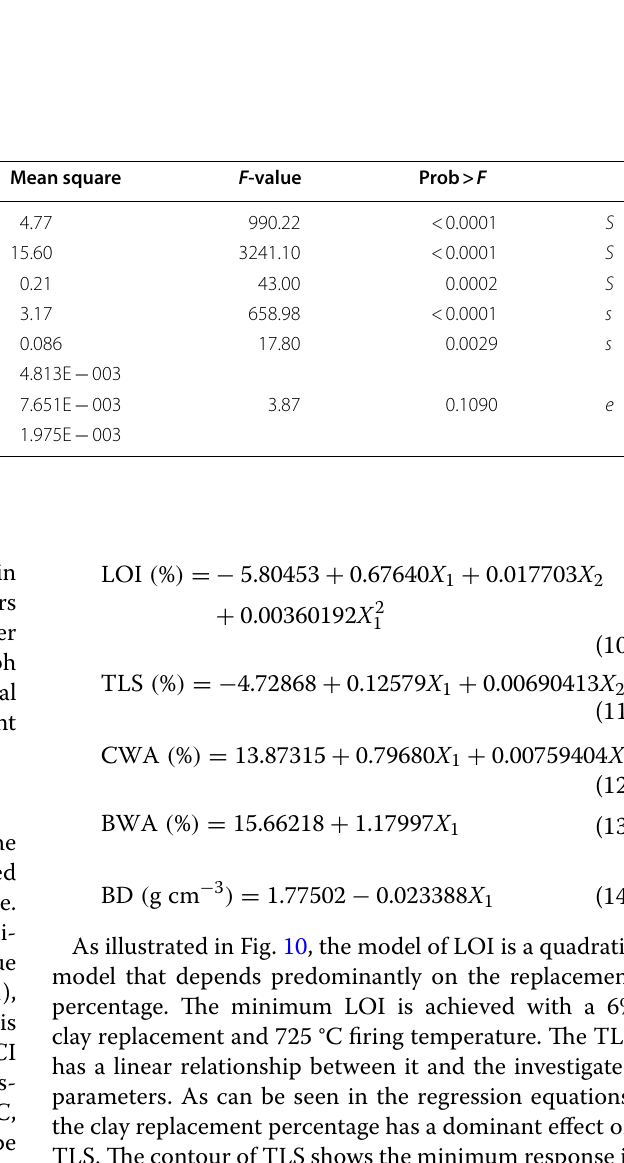
a Standard deviation b Adjusted residual squared